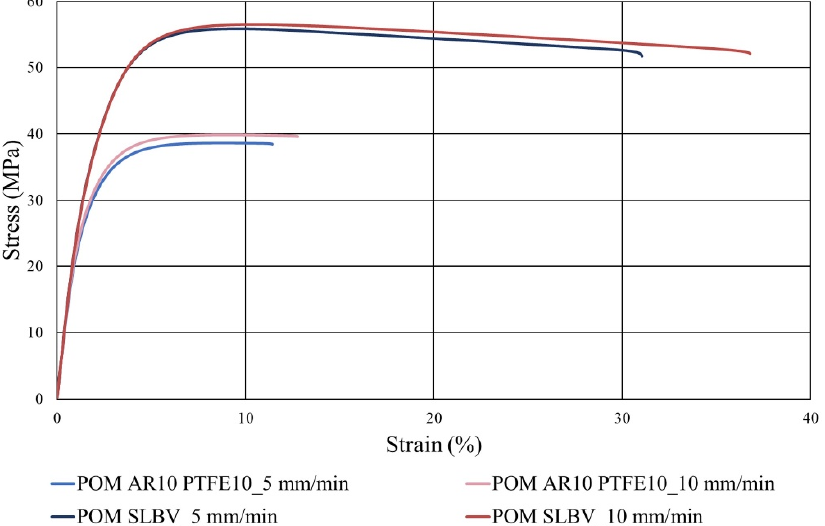
Figure 6. Stress–strain diagram recorded during the three-point bending test according to DIN EN ISO 178, n = 5. Table 4. Mechanical properties of the POM copolymers determined in a tensile test, according to DIN EN ISO 527-1 type 1A. Thermo-Plastic Material